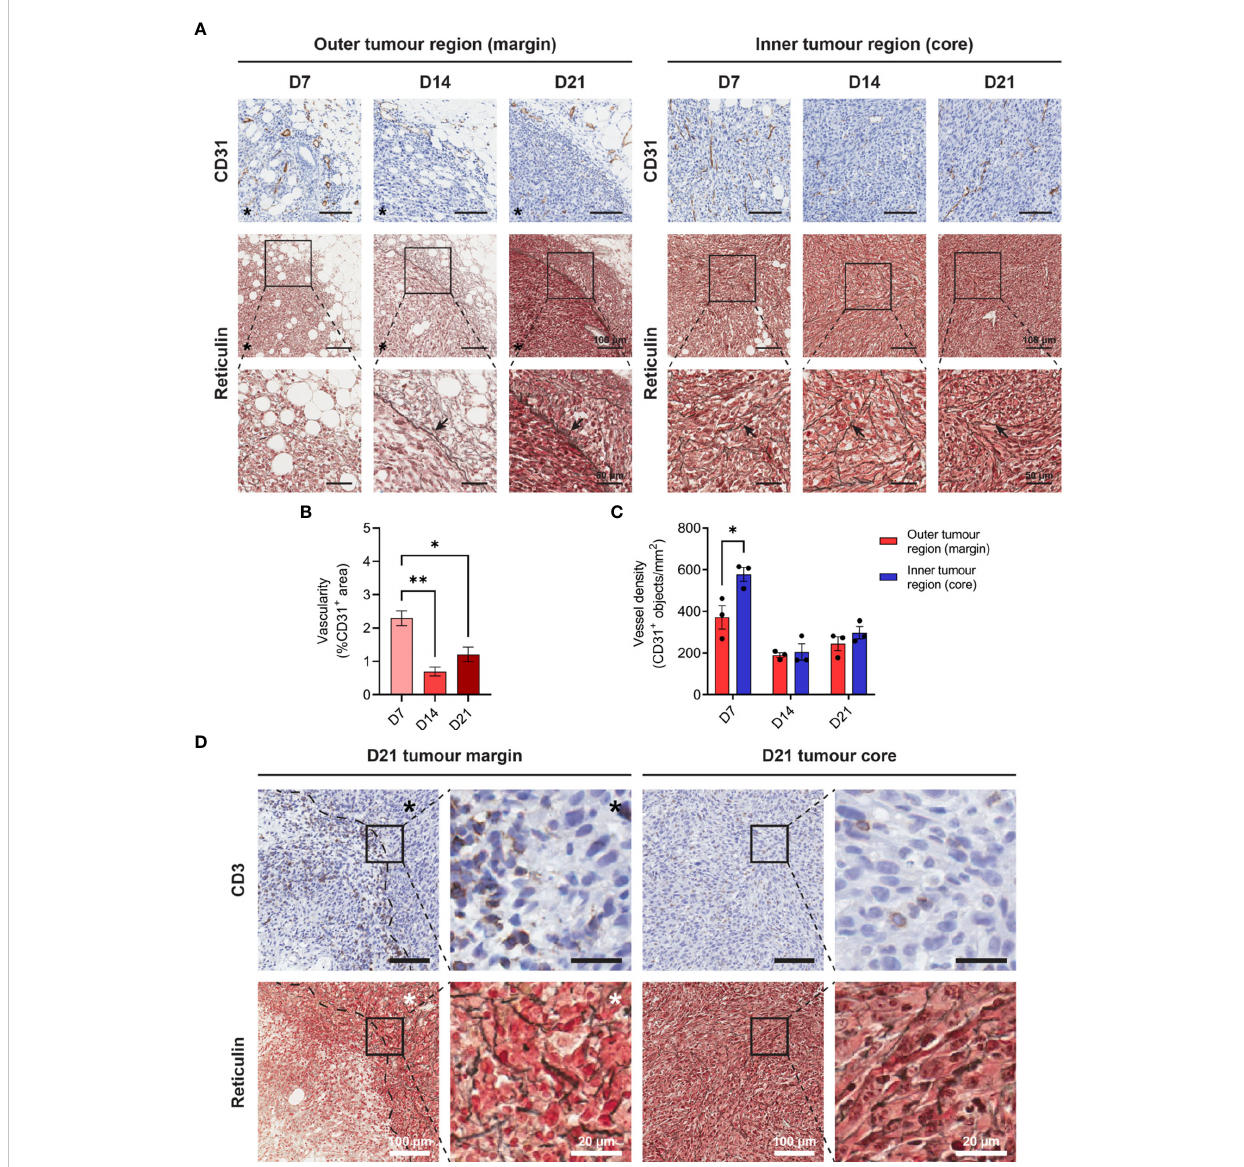
FIGURE 3 Angiogenesis, reticulin fi brosis, and immune exclusion in MC38 tumours. (A) MC38 tumours were resected from mice 7-, 14- and 21-days post- inoculation (n = 3 biological replicates per timepoint) and processed for CD31 IHC and reticulin staining. Images depict immunohistochemical staining for CD31 (brown with haematoxylin counterstain, top row) and reticulin silver staining of argyrophillic ‘ reticular fi bres ’ (black, arrows) with Nuclear Fast Red counterstain (nuclei, red). Scale bars depict 100 m m and 50 m m in low and high magni fi cation images, respectively. (B) Vascularity of MC38 tumours determined as the CD31 + area proportional to the total tumour area (%CD31 + area of total tumour). (C) CD31 + vessel density in the outer and inner regions of MC38 tumours at indicated timepoints. Vessel density was quanti fi ed as the absolute number of CD31 + blood vessels per mm 2 (CD31 + objects/mm 2 ). (D) CD3 IHC and reticulin staining of sequential D21 tumour sections. Top row images depict immunohistochemical staining for CD3 (brown) with haematoxylin counterstain (blue) and bottom row images depict reticulin staining for collagenous ‘ reticular fi bres ’ (black) with Nuclear Fast Red counterstain (red). Asterisks (*) denote the side of the tumour in images of the tumour margin. Scale bars depict 100 m m and 20 m m in low and high magni fi cation images, respectively. Graphs represent the mean and standard error of the mean (SEM, error bars). Statistical analyses were performed using one-way ANOVA with post-hoc Tukey test to correct for multiple comparisons (B) or two-tailed paired Student ’ s t-tests (C) . *p ≤ 0.05; **p ≤